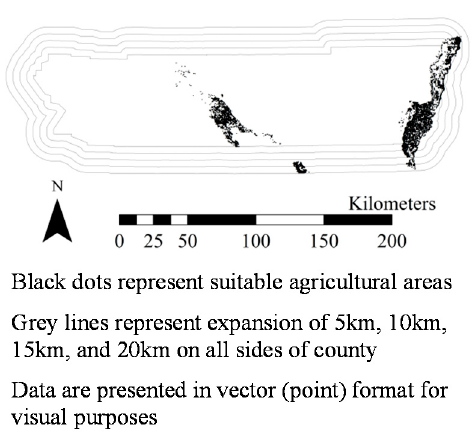
Figure 1. Suitable agricultural land for dates in Riverside County, California.